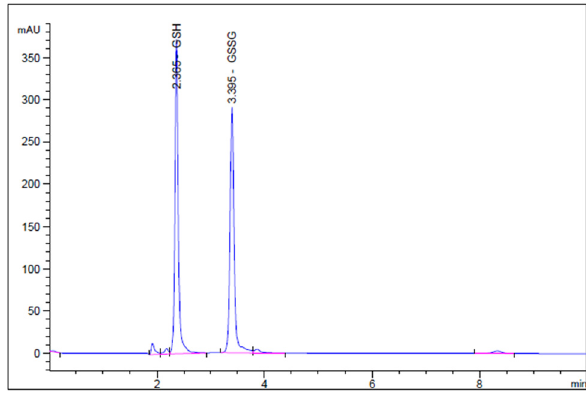
Figure 3: Representative RP - HPLC - generated chromatogram of a mixture of GSH ( 2.35 min ) and GSSG ( 3.39 min ) ( 5.0 µg/mL ) under optimized conditions.